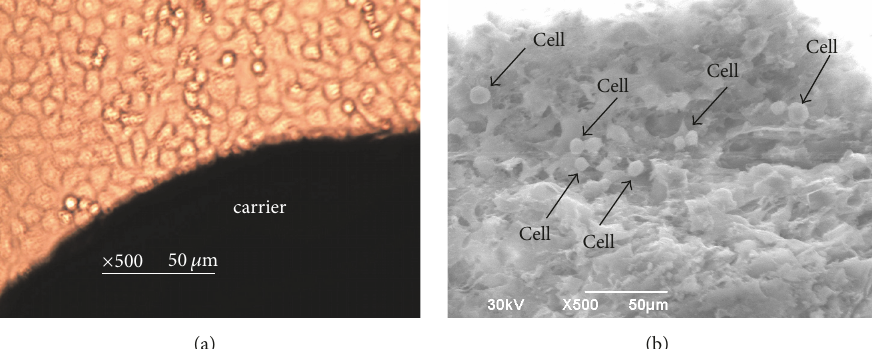
Figure 8: An inverted microscope image (a) and SEM image (b) of the human hepatocytes L-02 cultured on the spherical biocarriers.